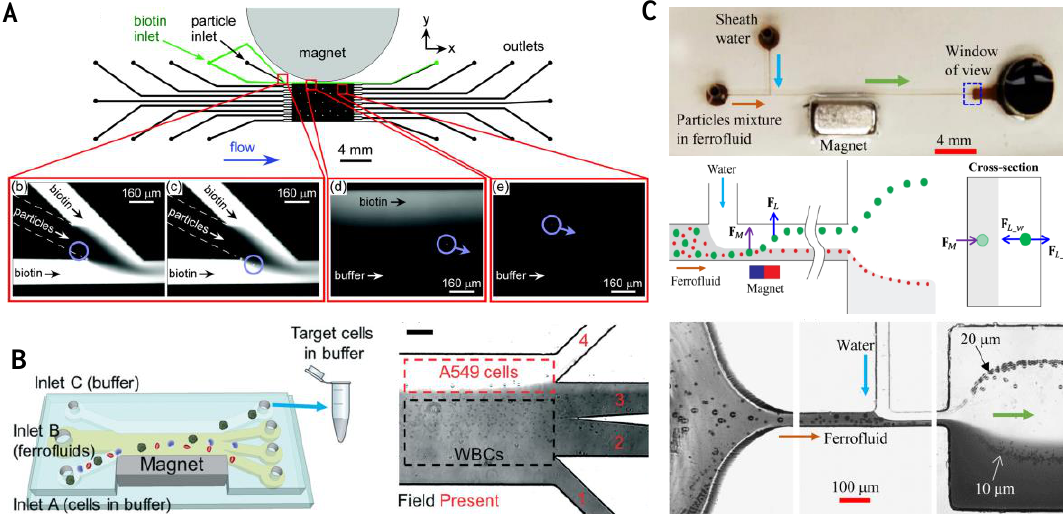
Figure 15. Continuous-flow washing of diamagnetic particles in magnetic fluids. ( A ) Schematic of the device and setup used for the diamagnetic repulsion-based streptavidin-biotin assay (top) and images showing the deflection of a polymer bead across multiple streams (bottom). Adapted with permission from Tarn et al. [164], © 2015 The Royal Society of Chemistry. ( B ) Schematic illustration of a biocompatible cell separation in a multiphase ferrofluid flow (left) and image of the separation / washing process of spiked cancer cells from WBCs at the end of the straight channel section (right). Adapted with permission from Zhao et al. [165], © 2017 The Royal Society of Chemistry. ( C ) Picture of the microfluidic device (top), schematic showing the mechanism of diamagnetic particle separation and washing in an inertial ferrofluid / water co-flow (middle), and experimental demonstration with 20 µ m and 10 µ m PS beads in 0.75 × EMG 408 ferrofluid (bottom). Adapted with permission with Chen et al. [166], © 2017 American Chemical Society.